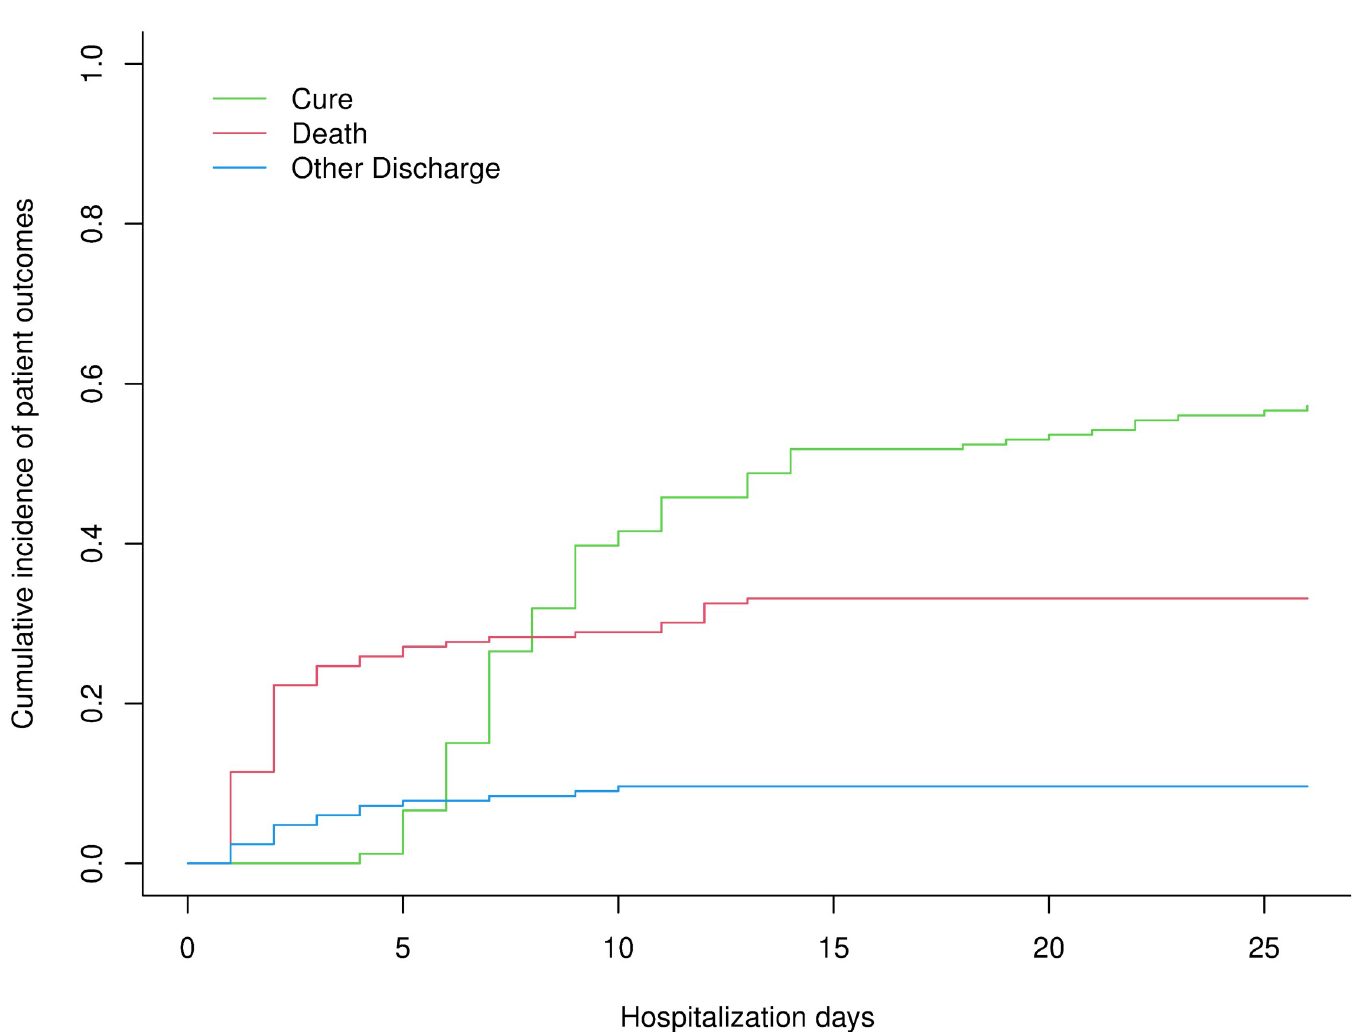
Fig 3. Cumulative incidence plots of neonatal outcome (red = death, green = cure, blue = early discharge). jaundice (45/168, 26.8%) being twice as prevalent as anemia (19/168, 11.3%). 25 children (16.3%) were treated with phototherapy. Congenital abnormalities (8/168, 4.8%) included pre- sumed Down syndrome ( n = 2), gastroschisis ( n = 1), encephalocele ( n = 1), VACTER-syn- drome ( n = 1), cleft palate ( n = 1), polydactyly ( n = 1), and club foot ( n = 1). One newborn had